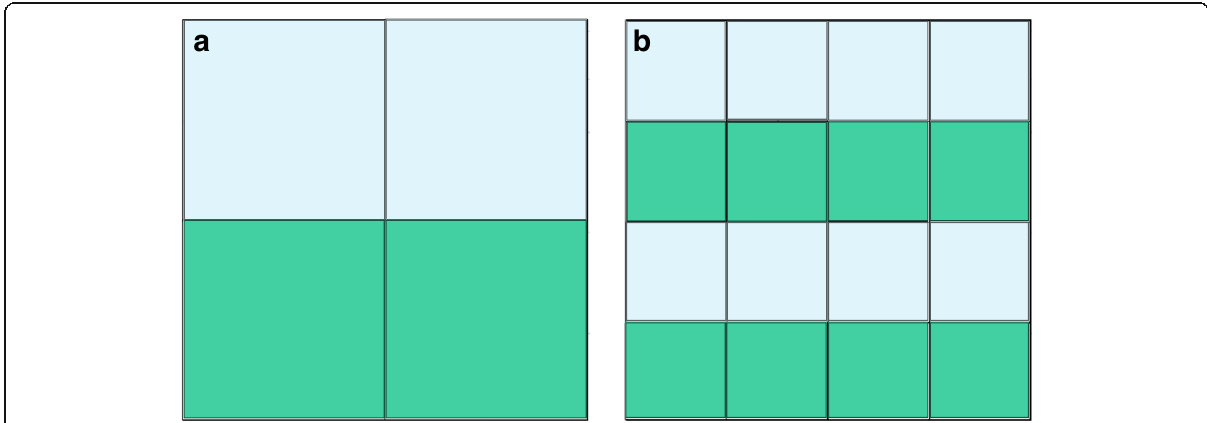
Fig. 7 CTUs with smooth texture features a . image with a simple horizontal texture b . image with multiple lines of simple horizontal orientation